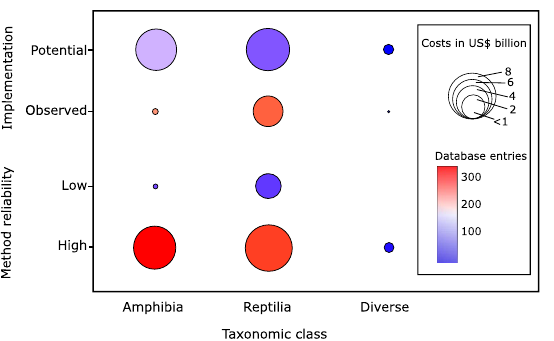
Figure 1. Global costs in US$ 2017 according to the type of implementation of cost ( Potential vs. Observed ) and method reliability ( Low vs. High ). The circle sizes indicate cost in US$ and the colours indicate the number of entries.